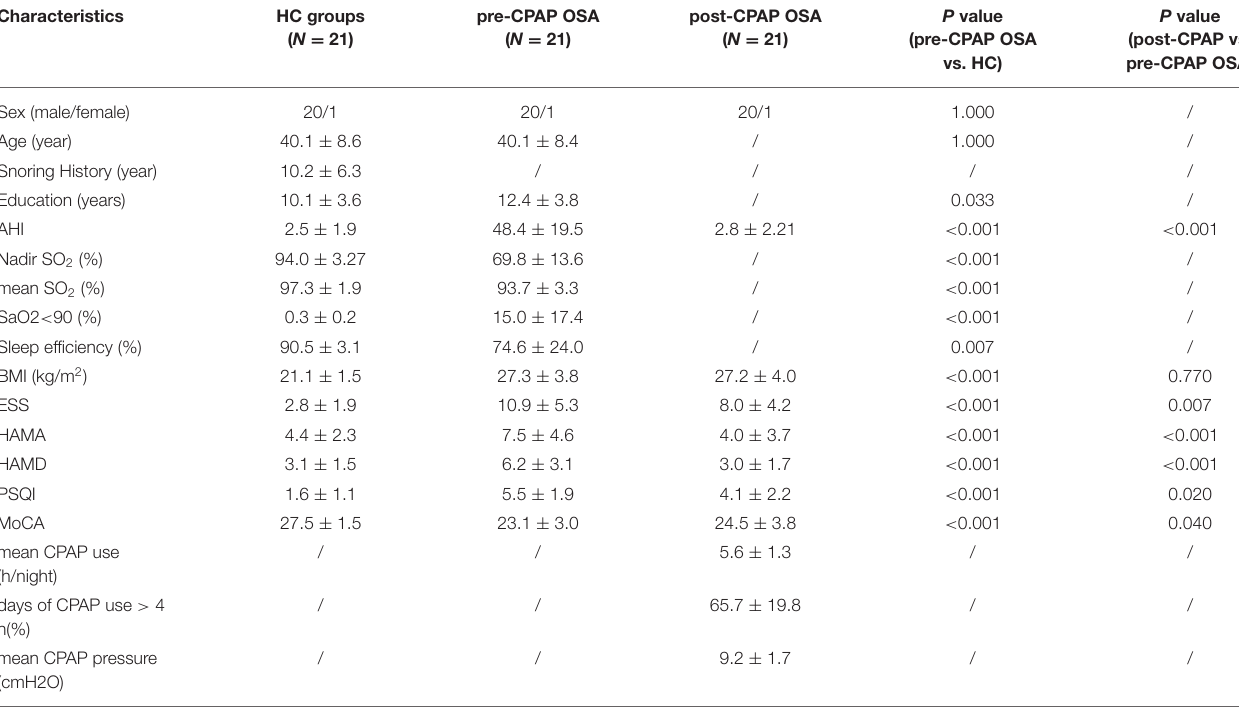
TABLE 1 | Population and clinical characteristics of participants.